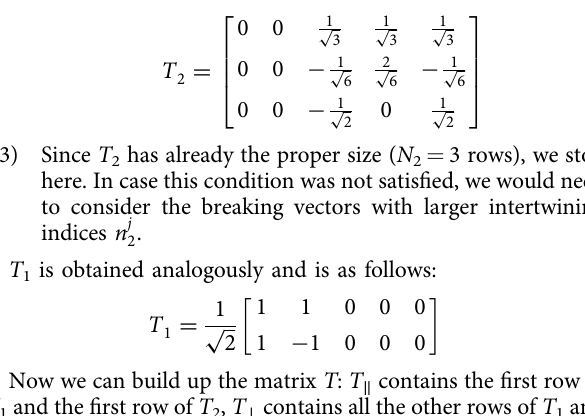
Fig. 4 Matrices T and B for the example of Fig. 2, partition P . a Structure of the matrix T , with the rows of T ⊥ color-coded as the corresponding clusters. b Complete matrix B . The transverse block B ⊥ (within the dashed borders) has an upper triangular structure, containing two subblocks with nonzero entries (color-bordered blocks). The upper subblock (with red and blue borders) characterizes (see the corresponding rows in the T structure) the perturbation affecting clusters C 2 ( fi rst row of the subblock), which depends on both clusters, and the one affecting C 1 (second row), which depends only on C 1 (single diagonal entry). The red scalar subblock evidences a second perturbation affecting cluster C 2 , which is independent of cluster C 1 . Therefore, C 1 is an independent cluster, whereas C 2 is one- way-dependent on C 1 Table 1 and that are orthonormal to the other rows of T 2 :